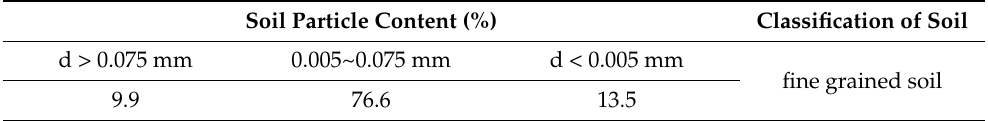
Figure 1. Field trip map of the dredger. The grain composition of soil samples was determined by sieve analysis and hydrom- Table 1. Soil particle